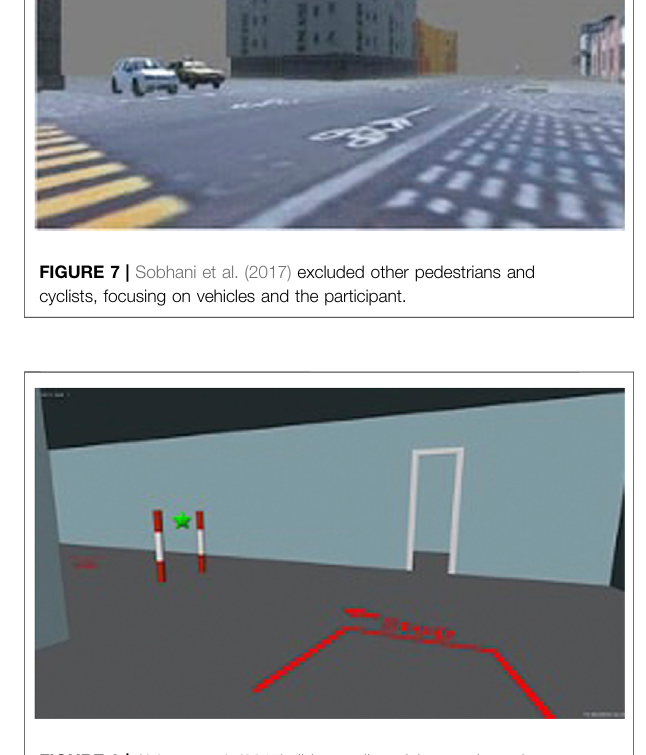
Frontiers in Virtual Reality |